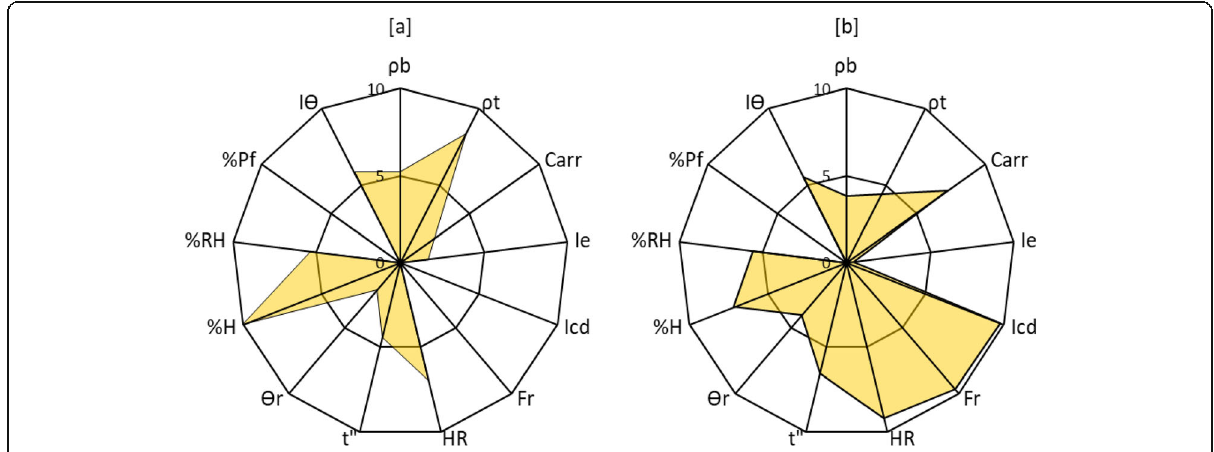
Fig. 1 SeDeM diagrams of corn starch ( a ) and microcrystalline cellulose ( b )